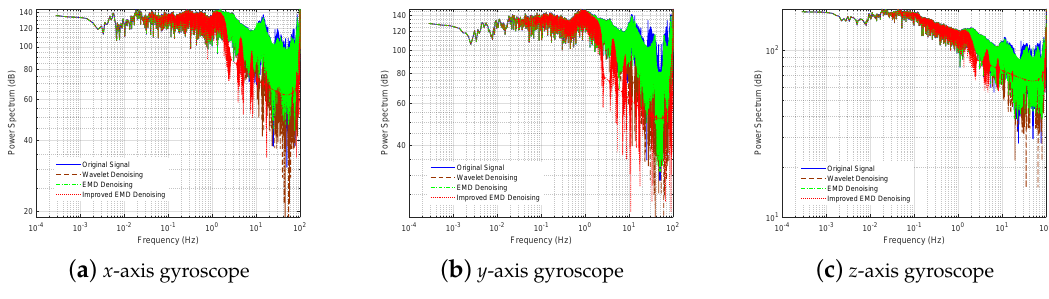
Figure 8. Power spectrum of gyroscope by uitilizing muliple denoising methods.